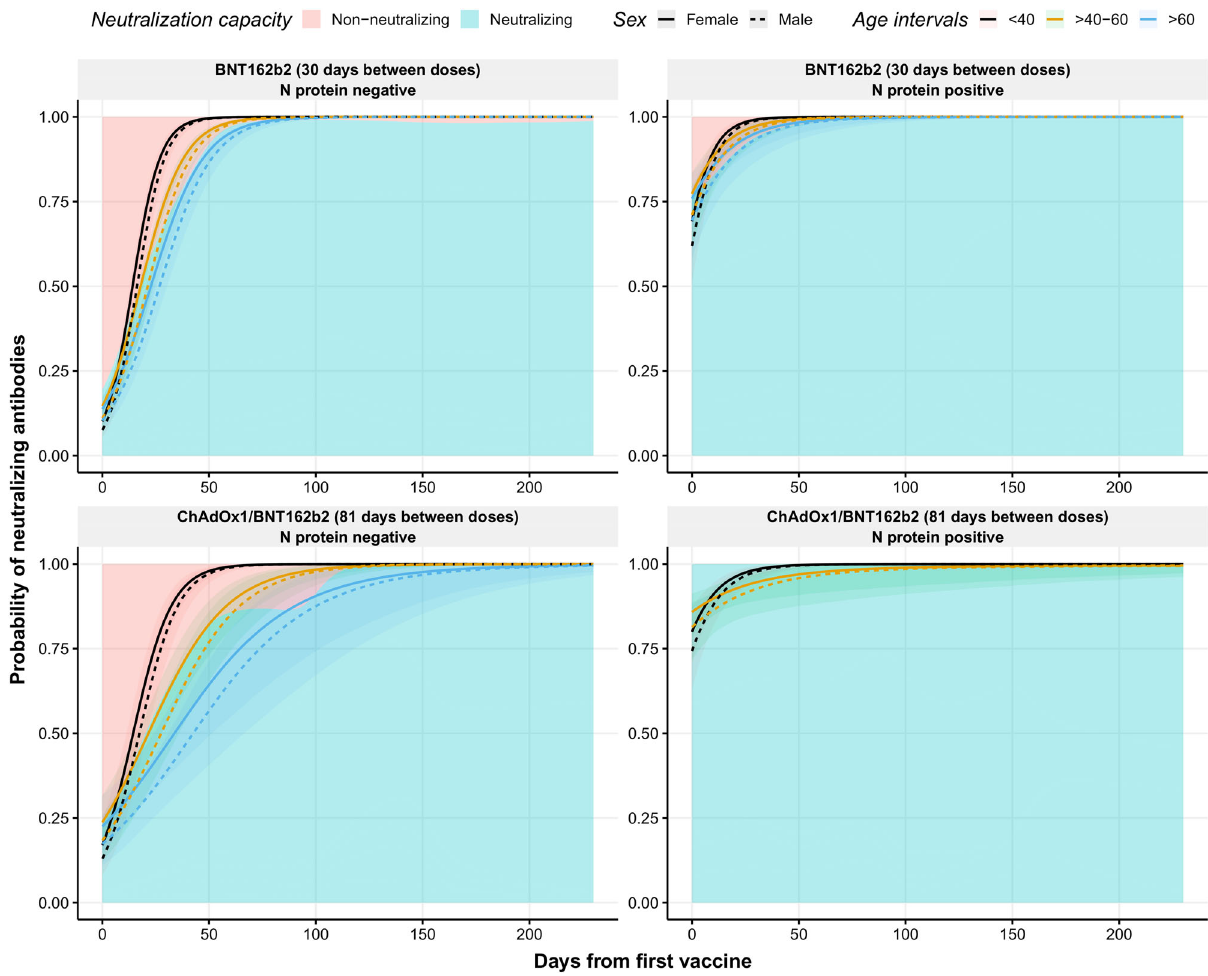
Fig. 4 Observed and predicted the probability of neutralizing antibodies against RBD after the fi rst dose of the COVID-19 vaccination. Distribution of neutralizing antibodies (probability) over time (days from the fi rst vaccine) in individuals with no prior infection vaccinated with BNT162b2 (top left) or with the combination ChAdOx1/BNT162b2 (bottom left), and in individuals previously infected and vaccinated with BNT162b2 (top right) or with the combination ChAdOx1/BNT162b2 (bottom right). Blue and pink backgrounds represent the conditional density estimation of neutralizing and non- neutralizing antibodies index, respectively. Solid and dashed lines across the graph represent the predicted probability of neutralizing antibodies index calculated by the model in females and males, respectively. Black, yellow, and blue colors represent individuals with age <40, 40 – 60, and >60 years, respectively. Shadowed areas represent the 95% con fi dence interval. Center for the con fi dence interval is the predicted (mean)